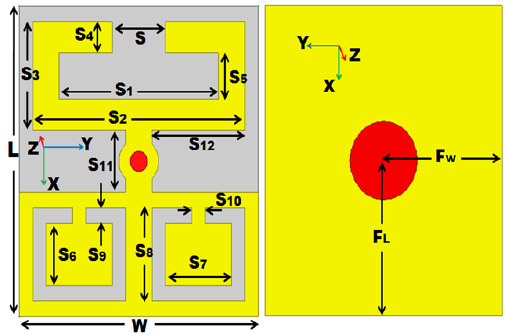
Figure 3. Detailed layout of the proposed design L = 20 mm, W = 18 mm, F L = 10 mm, F W = 9 mm, S =